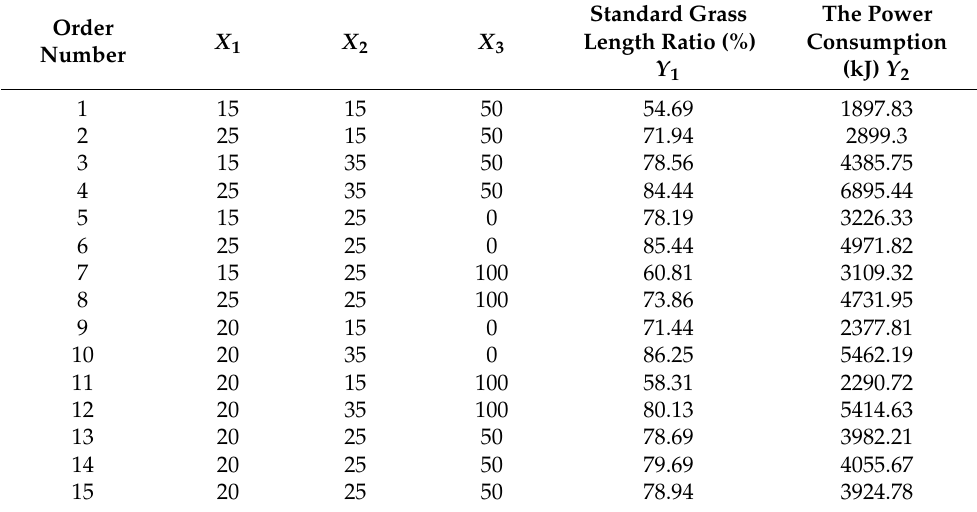
Table 2. Experimental scheme and results.